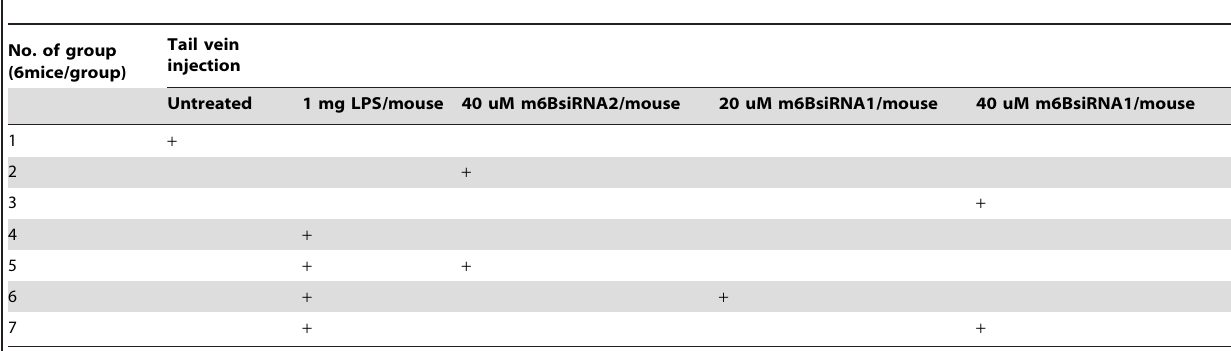
Table 1. Tail vein injection of E.coli LPS plus 6BsiRNA1 or 6BsiRNA2 as the